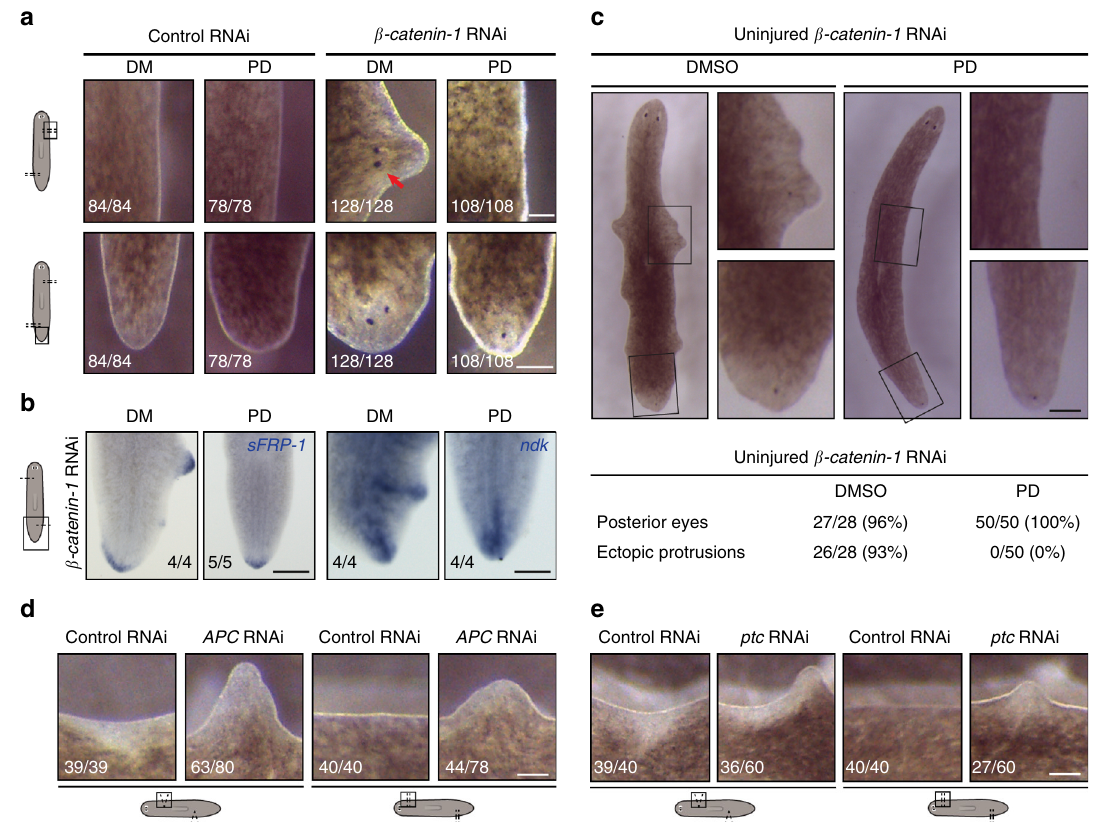
Fig. 4 H-wounds in fl icted on planarians with altered levels of Wnt signaling induce patterned outgrowths. a , b Simple incisions applied to β -catenin-1 RNAi planarians induced accessory heads, which were not observed when ERK activation was inhibited by PD, or in control RNAi animals. Sample numbers indicated in each image. In contrast, ectopic heads formed in existing posterior tissues were unaffected by PD treatment. Arrow, ectopic eyes; sFRP-1 , anterior marker; ndk, marker for the brain region. c Similarly, ectopic lateral outgrowths but not posterior heads in homeostatic β -catenin-1 RNAi animals were inhibited by treatment with PD. d – e Outgrowths were also induced by lateral incisions in fl icted on APC ( d ) or patched ( e ) RNAi planarians, which undergo direct 28 – 30 or indirect 31 ectopic activation of Wnt signaling. To increase the penetrance of outgrowth formation in ( a ), ( d ), and ( e ), two incisions were made instead of one. Numbers refer to injured areas (two per animal); scale bars: 100 μ